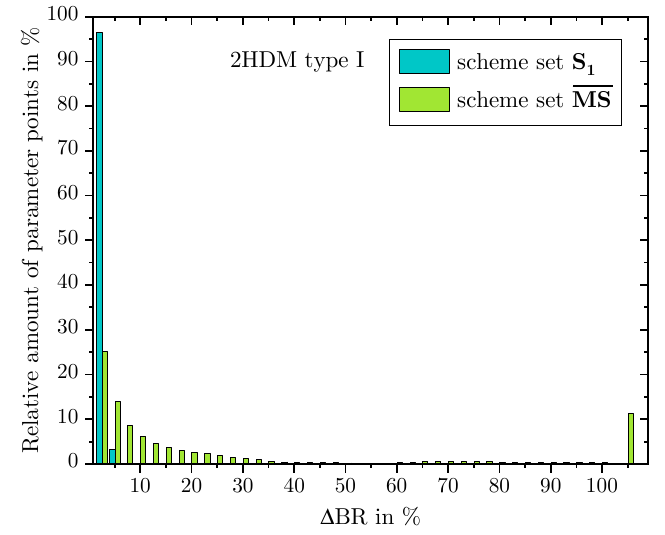
Figure 1 . 2HDM type I: binned amount of parameter points in % for the scheme sets S 1 S 1 S 1 (blue) and MS MS MS (green) as a function of (cid:1)BR in % for the decay h ! b (cid:22) b . All points with corrections above 100% are collected into one